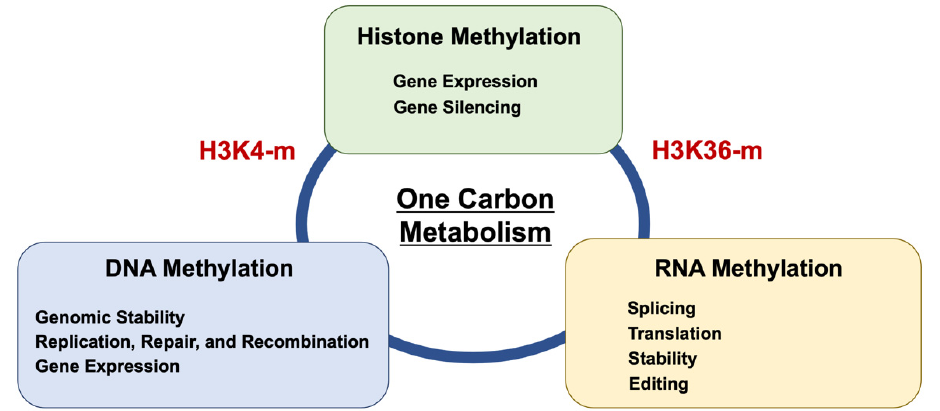
Figure 3. Biochemical linkage and competition of methylation among DNA, RNA, and histone. One-carbon metabolism links the methylation reaction. DNA methylation is mediated by H3K4 methylation [18]. Histone H3 trimethylation at lysine 36 guides m6A RNA modification [19]. Epigenetic methylation of N6-adenine and N6-adenosine with the same input resulted in different output in various biological aspects